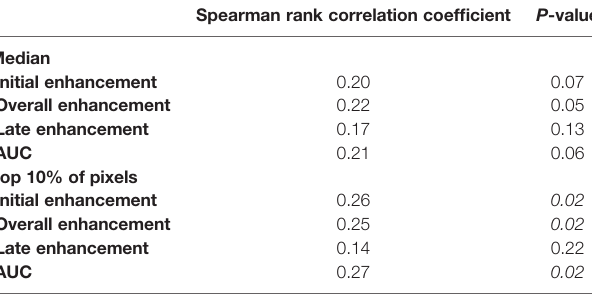
TABLE 3 | Correlation analysis of BPE metrics with continuous Oncotype Dx